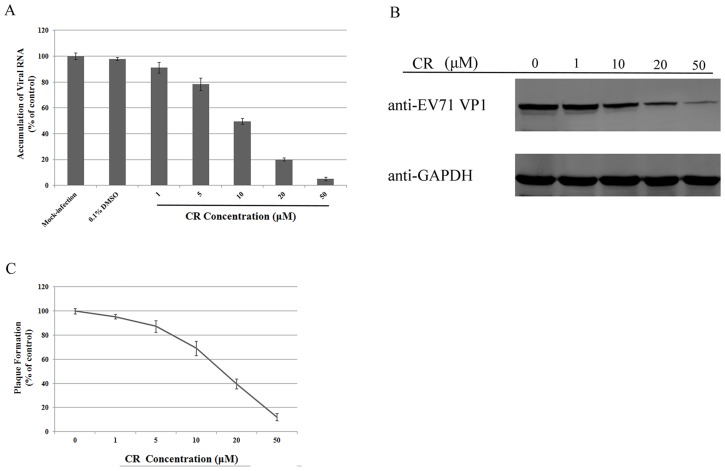
CR inhibits EV71 replication in RD cells.(A), (B) CR inhibited the accumulation of EV71 RNA and capsid protein VP1 synthesis in RD cells (P<0.05). (C) EV71 plaque formation was reduced by the addition of CR (P<0.05). The experiment was performed in triplicate; bars represent means ± SD.